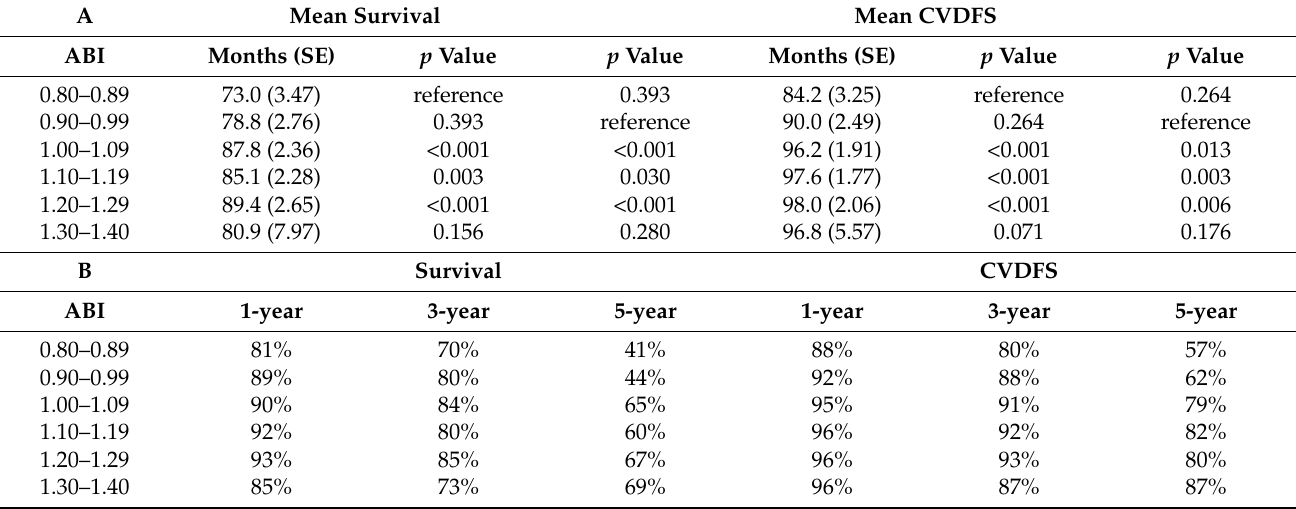
Table 3. Survival and ABI range categories. The estimated overall survival and cardiovascular-death- free survivals in months (SE) of the ABI range categories are presented in Table 3A. Table 3B shows 1-, 3-, and 5-year survival rates for each category.